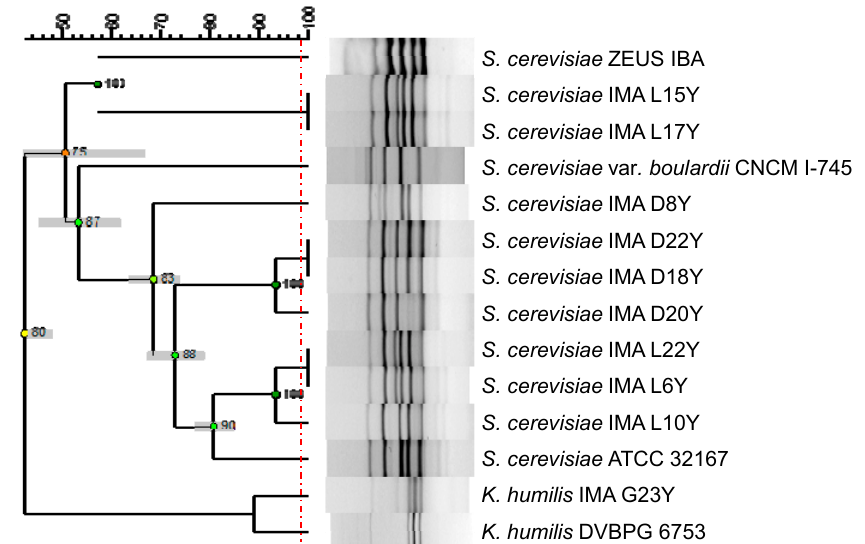
Figure 1. Dendrogram obtained from unpaired group method with arithmetic average (UPGMA) analysis, using Dice’s coefficient, based on inter-delta profiles of the 10 yeast strains tested, along with the commercial baker’s yeast Zeus IBA, the commercial probiotic S. cerevisiae var. boulardii CNCM I-745 (Collection Nationale de Cultures de Microorganismes, Institut Pasteur, Paris, France) and the two reference strains. The red line indicates the similarity value (98.7%) for separation of biotypes. Standard deviation is shown at each node by a grey bar. Cophenetic correlation is shown at each branch by numbers and coloured dots, ranging between green-yellow-orange-red, according to decreasing values.